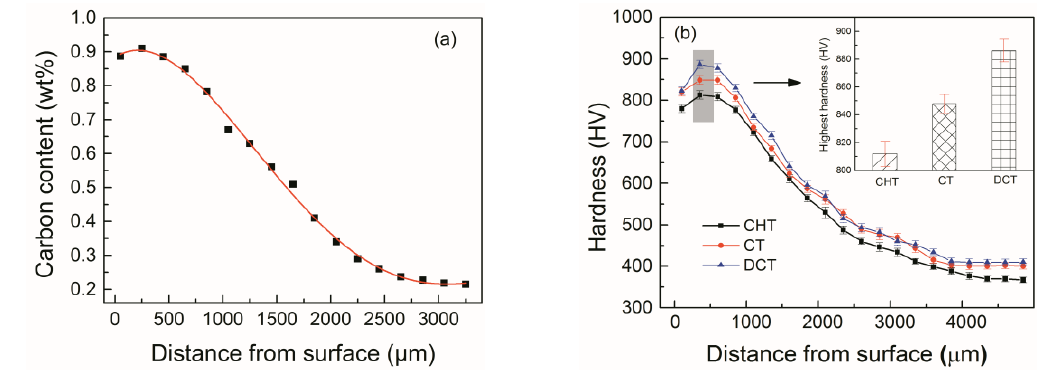
Figure 3. Carbon content gradient of samples after carburizing process ( a ) and hardness gradient of samples under different heat treatments ( b ).